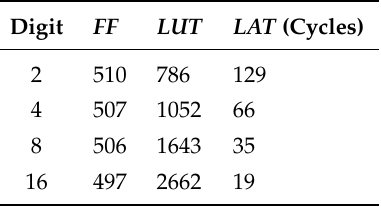
Table 4. Preliminary results for the digit-based multiplier on F 2 251